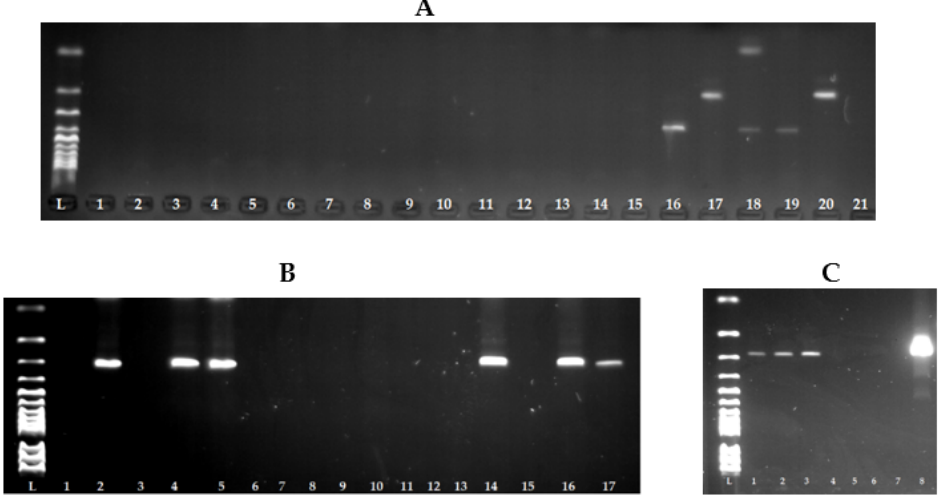
Figure 2. Detection of genes encoding the staphylococcal enterotoxins of Staphyoccocus warneri using the PCR method. ( A ) L: 100 bp ladder; lines 1–15: isolates S. warneri without genes